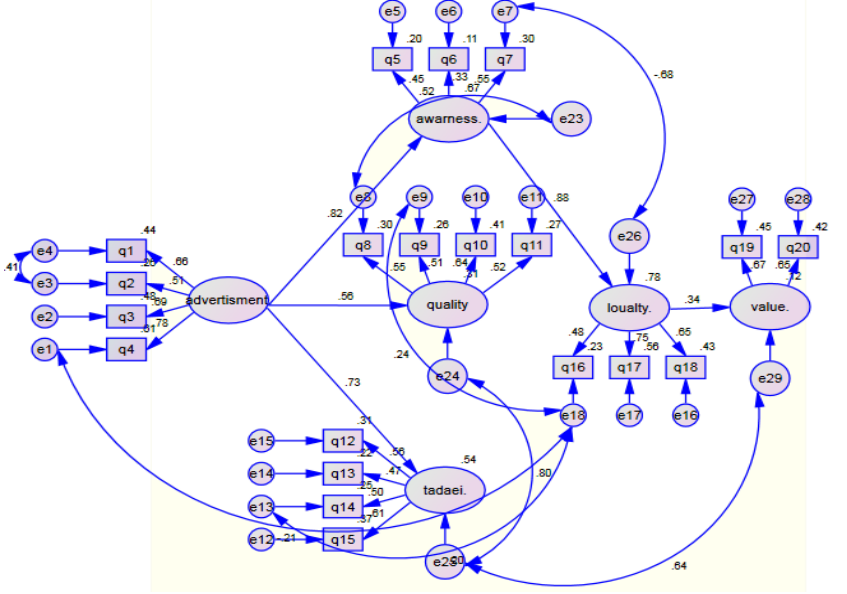
Fig. 1. The results of standard coefficients (tadaei: Brand